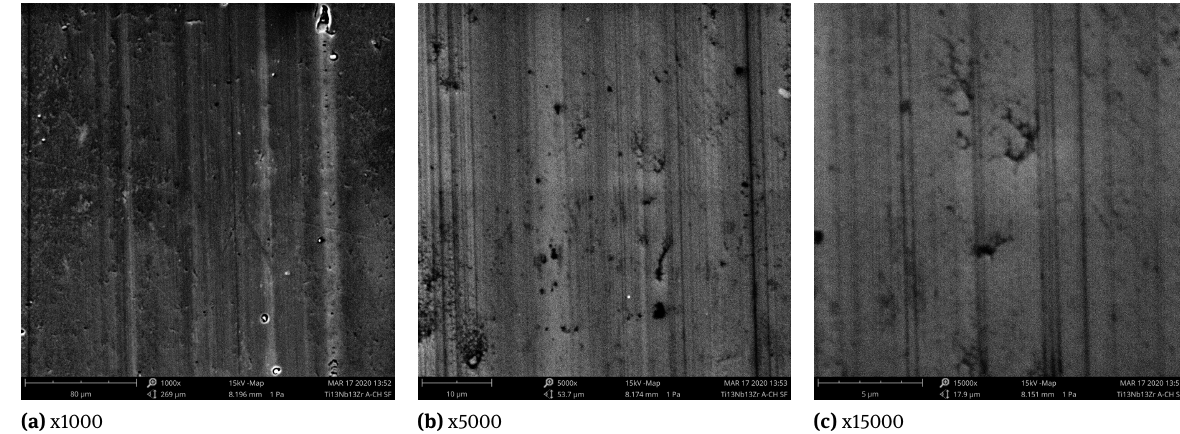
Figure 13: Surface morphology of the wear traces after friction with synovial fluid (SF) for Ti13Nb13Zr